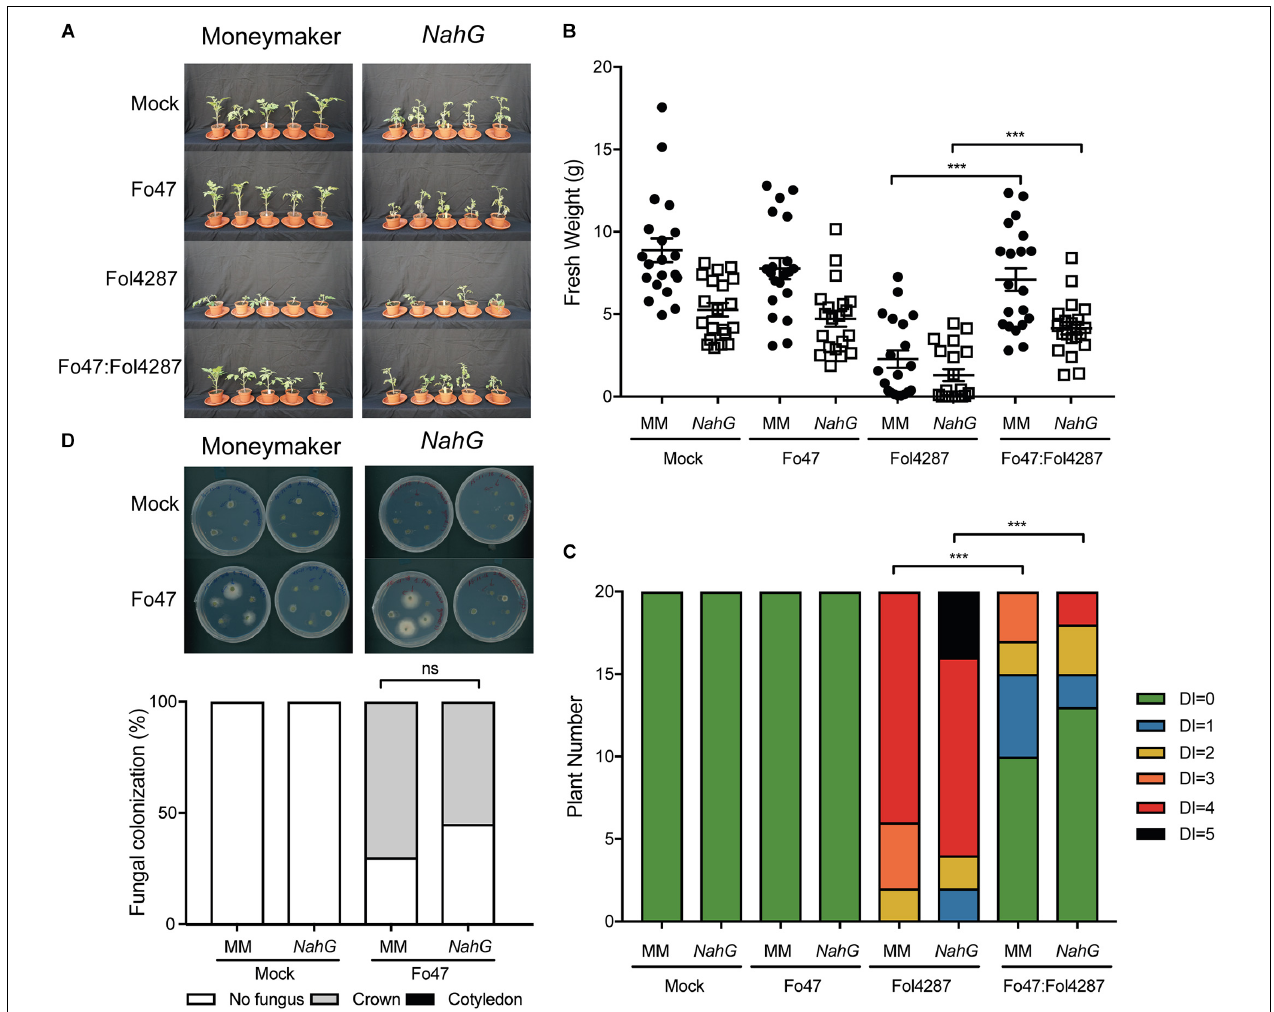
FIGURE 2 | Impaired SA signaling does not affect EMR triggered by Fo47. (A) Ten days old tomato seedlings (Moneymaker) and transgenic NahG plants impaired in SA accumulation were inoculated with water (mock), Fo47, Fol4287 or co-inoculated with Fo47 and Fol4287. Disease development was assessed by measuring fresh weight (B) and disease index (C) 3 weeks after inoculation. Raw data was analyzed by a non-parametric Mann–Whitney U -test ( ∗∗∗ P < 0.001). The bioassay was performed three times with similar results, where the number of plants (n) was n = 10 for the first repetition and n = 20 for the second and third repetition. (D) Representative stem pieces harvested from crown (left) and cotyledon (right) level of five individual plants incubated for 4 days on PDA plates. Percentage of Fo47 colonization on mock-inoculated plants ( n = 10) and Fo47-treated plants ( n = 20). The experiment was performed three times with similar results. Raw data was analyzed by a non-parametric Mann–Whitney U -test ( ∗∗∗ P <